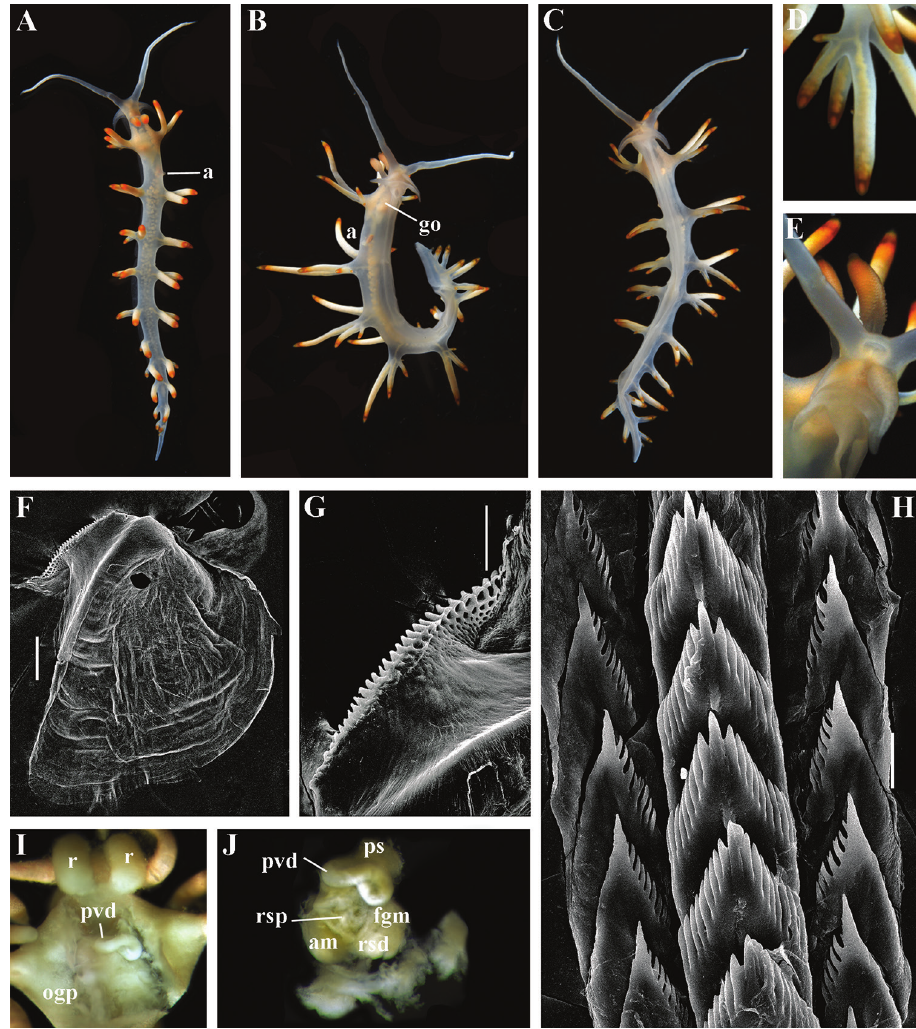
Figure 47. Samla takashigei sp. n. Japan, Pacific Honshu, Osezaki. ZMMU Op-530, living specimen 26 mm in length: A dorsal view B lateral view C ventral view D details of cerata E rhinophores F jaw, SEM G details of masticatory process of jaw, SEM H radular teeth, posterior part, SEM I dissected an- terior part with reproductive system, light microscopy J reproductive system, light microscopy. Abbrevia- tions: a anus am ampulla fgm female gland mass go genital opening ogp oral gland penetrating into basis of cerata ps penial sheath pvd prostatic vas deferens r rhinophores rsd distal receptaculum seminis rsp proximal receptaculum seminis. Scale bars: F = 100 μm; G = 50 μm; H = 20 μm. Photos and SEM images by T.A. Korshunova, A.V.